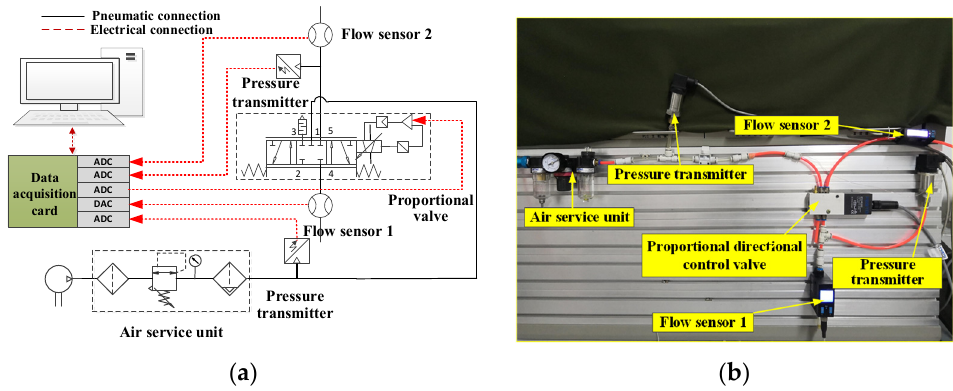
Figure 10. Tests of the pneumatic circuit of the flow coefficient of the proportional valve: ( a ) schematic; ( b ) experimental test platform.